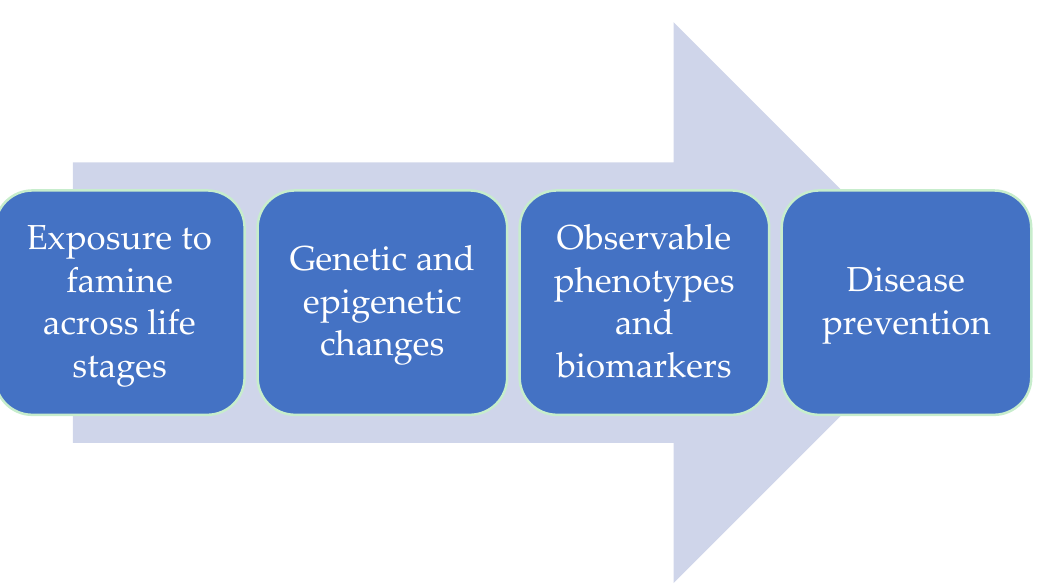
Table 1. The selected cohorts and the number of articles for each cohort. Study Cohort Context